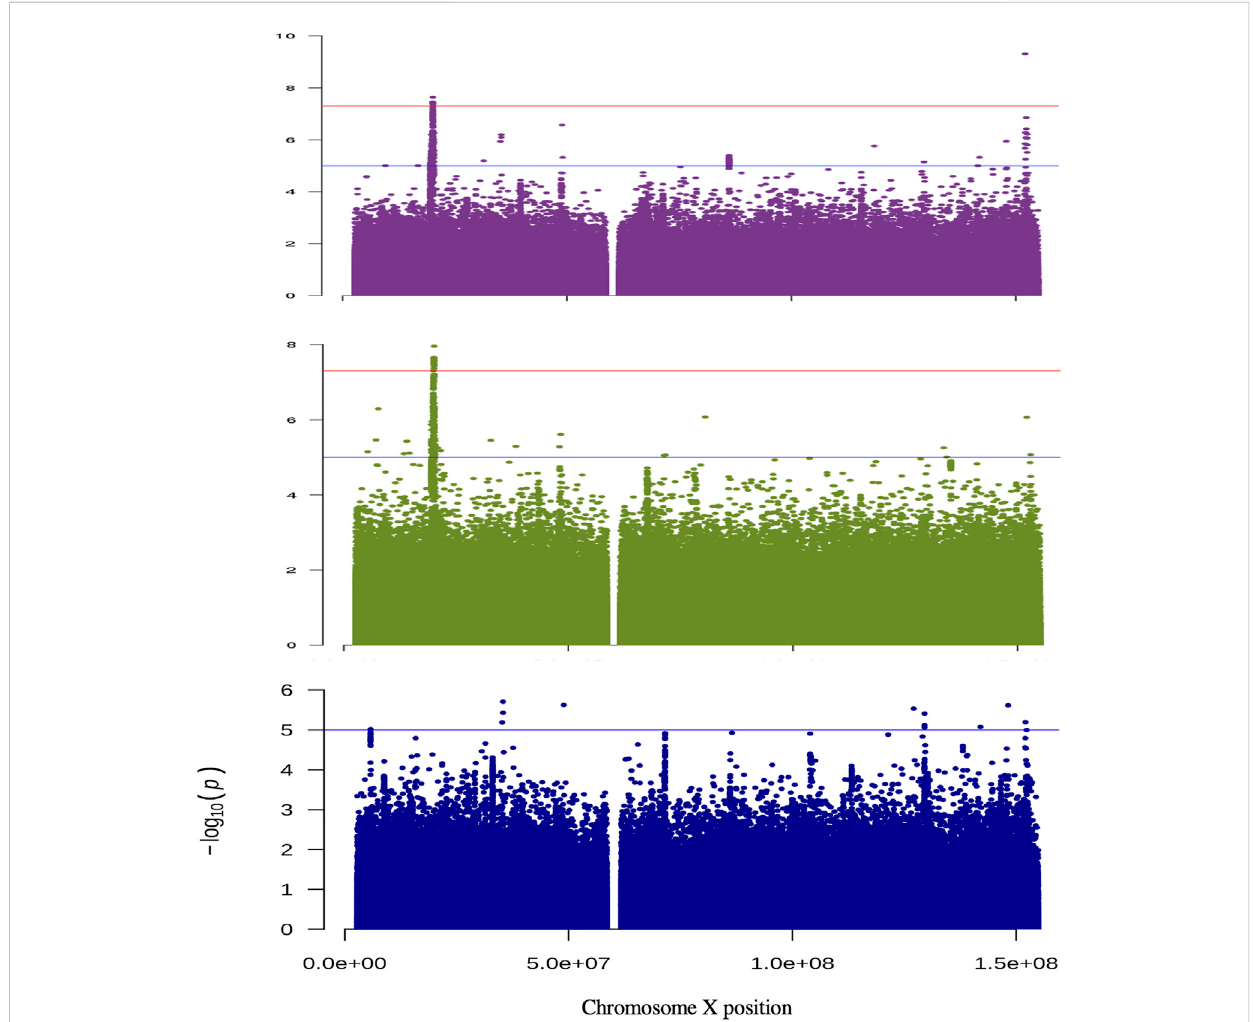
FIGURE 1 Manhattanplotsfortheanalysisofnon-pseudoautosomalregionoftheXchromosome.Theresultsareshownfortheanalysisof H-Both :malesand females(purple);femalesonly(green)andmalesonly(blue).The y -axisdisplays − log 10 foreachvarianttestedandthe X -axistheirposition.Thehorizontal red and blue lines show the threshold for genome-wide signi fi cant ( p = 5 × 10 − 8 ) and suggestive ( p = 1 × 10 − 5 ) associations,